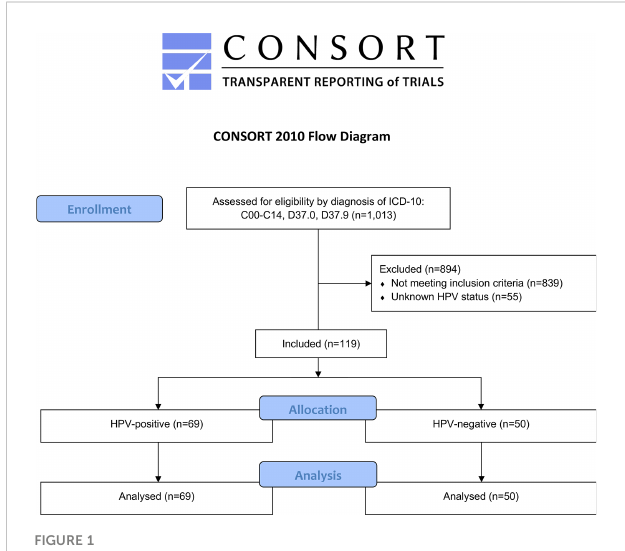
FIGURE 1 Modi fi ed CONSORT fl ow diagram of patient